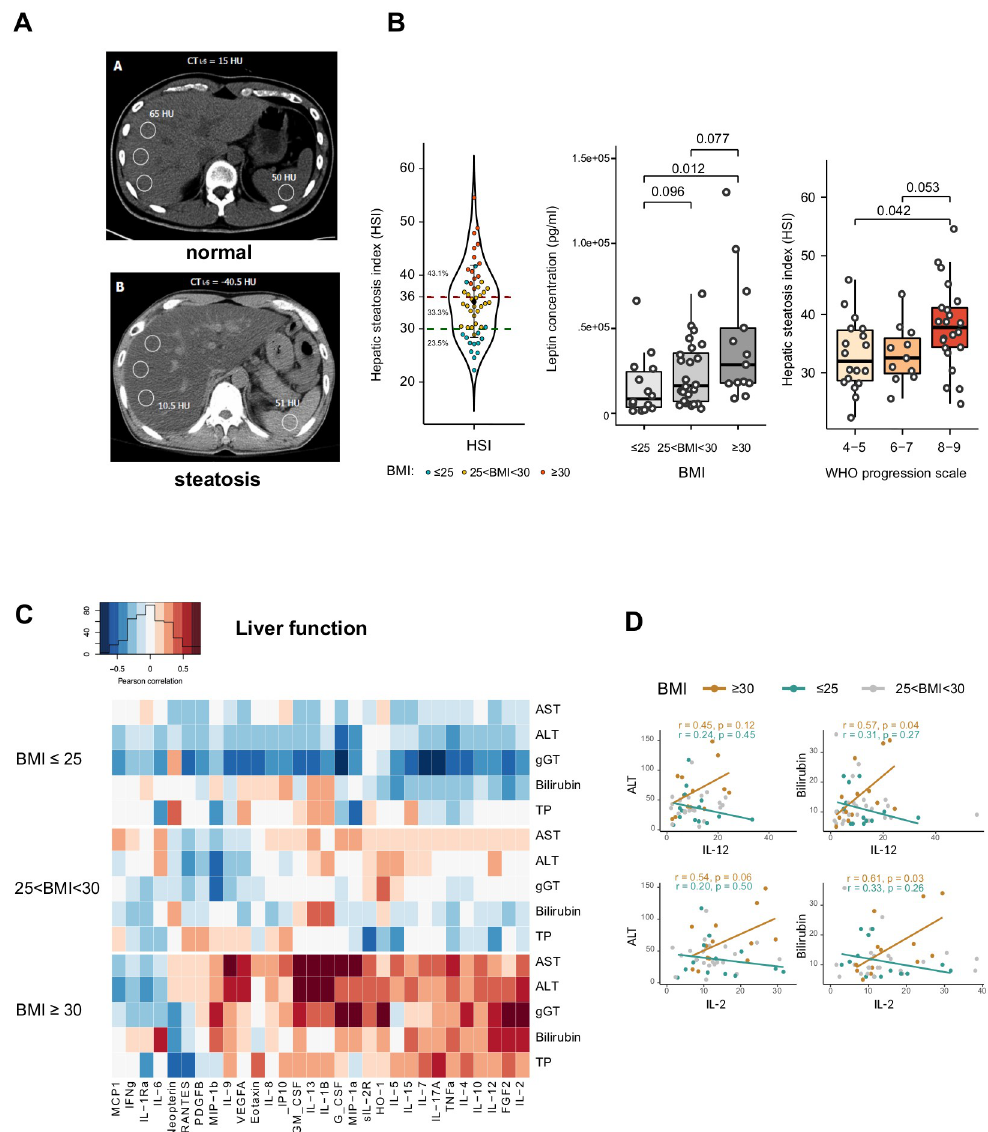
Fig 3. (A) Axial computed tomography images showing normal (up) and low attenuation (down) values of the liver parenchyma reflecting steatosis (n = 23). (B) Left panel: violin plot representing the biological hepatic steatosis index (HSI) according to BMI ( � 25 in green, 25 < BMI < 30 in yellow, � 30 in red). Middle panel: Box plots depicting the plasma leptin levels of patients (n = 51) according to BMI (BMI � 25, 25 < BMI < 30, � 30). Wilcoxon-Mann-Whitney test used for pairwise comparisons Left panel: Box plots representing the HSI levels according to severity of pulmonary distress (the WHO scale). (C) The Pearson correlation heatmap depicts the negative (blue), positive (red), and no (white) correlation between markers of liver dysfunction (AST, ALT, gGT, TBIL, and PT) and the blood cytokines levels in in patients (n = 51) according to BMI (BMI � 25, 25 < BMI < 30, BMI � 30). (D) Linear regression curves estimated between ALT, total bilirubin, and plasma concentration of IL-1 β , IL-12 and IL-2 in non-overweight patients (BMI � 25, in light blue) and in patients with obesity (BMI � 30, in dark blue). Patients with 25 < BMI < 30 are presented in